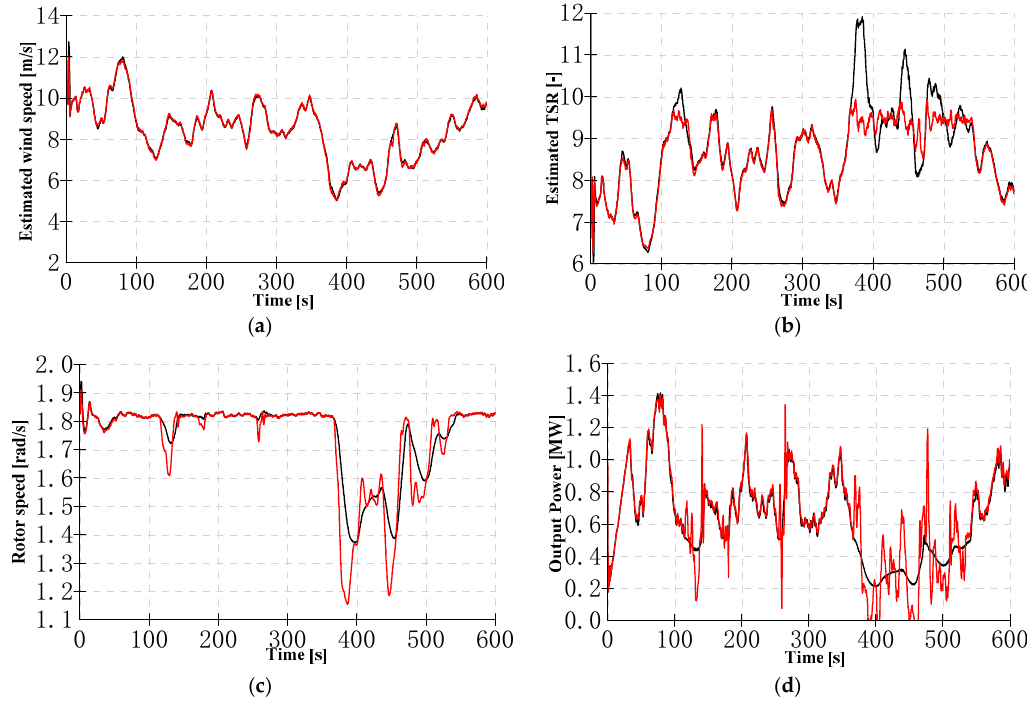
Figure 7. Simulation results under Case 3 with mean speed of 8 m/s and TI of 0.203.